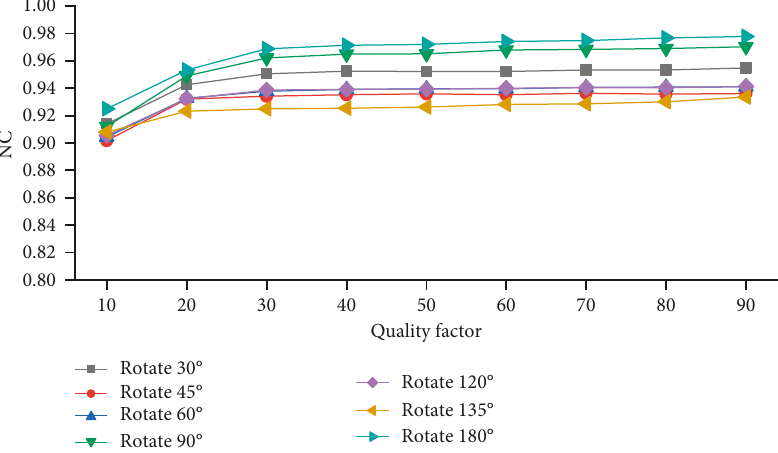
Figure 16: NC mean under combined attack of rotation and JPEG